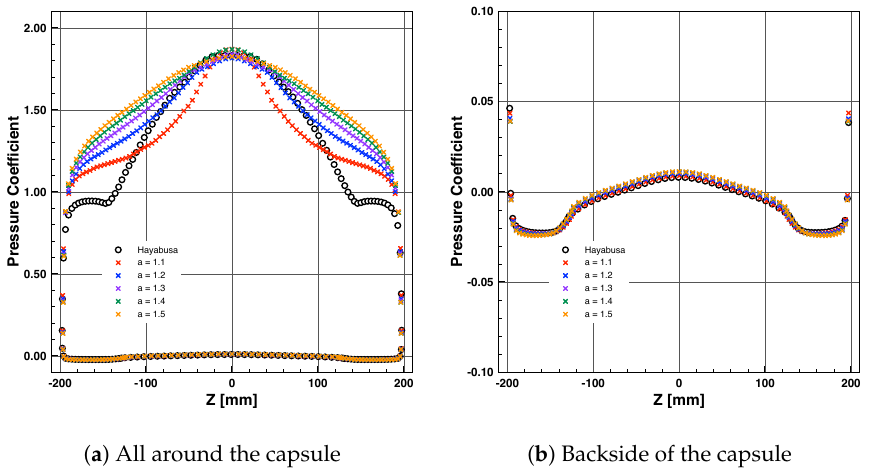
Figure 6. Pressure coefficient distribution on the symmetry plane with different hyperbolic contours at an AoA of 0